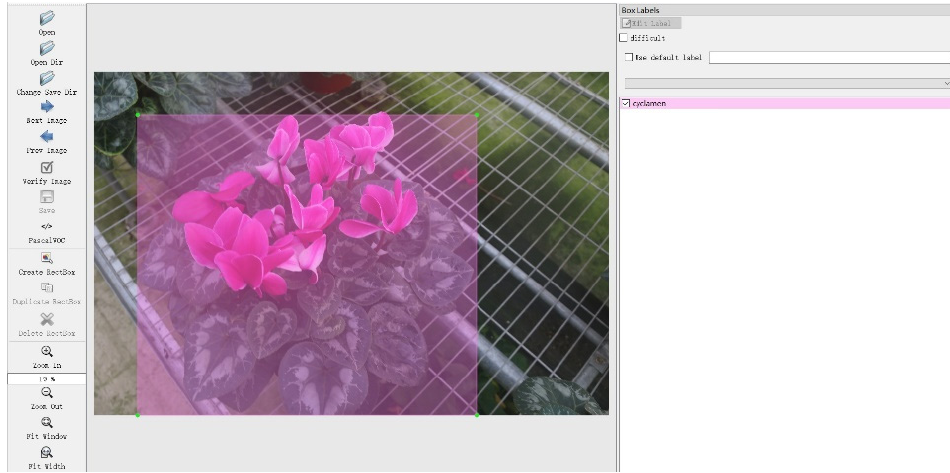
Figure 4. Labeling the training dataset using LabelImag.